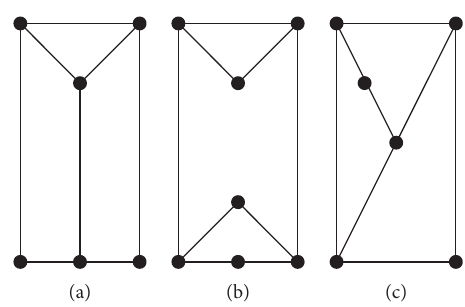
Figure 2: Edge-equivalent graphs. (a) D